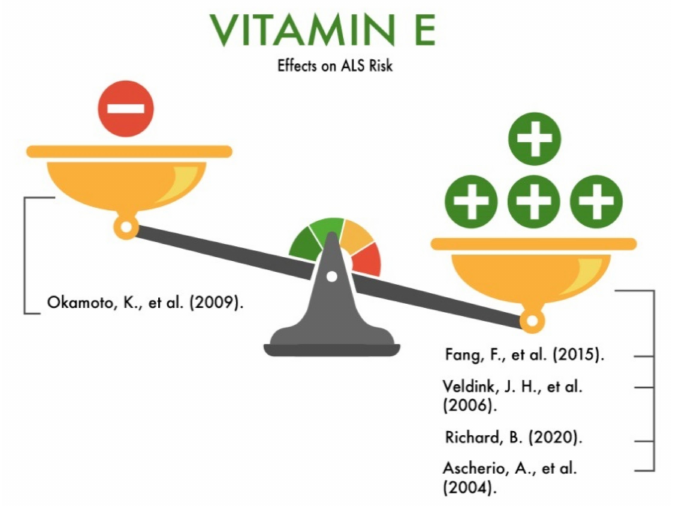
Figure 9. The effects of vitamin E on the risk of developing amyotrophic lateral sclerosis